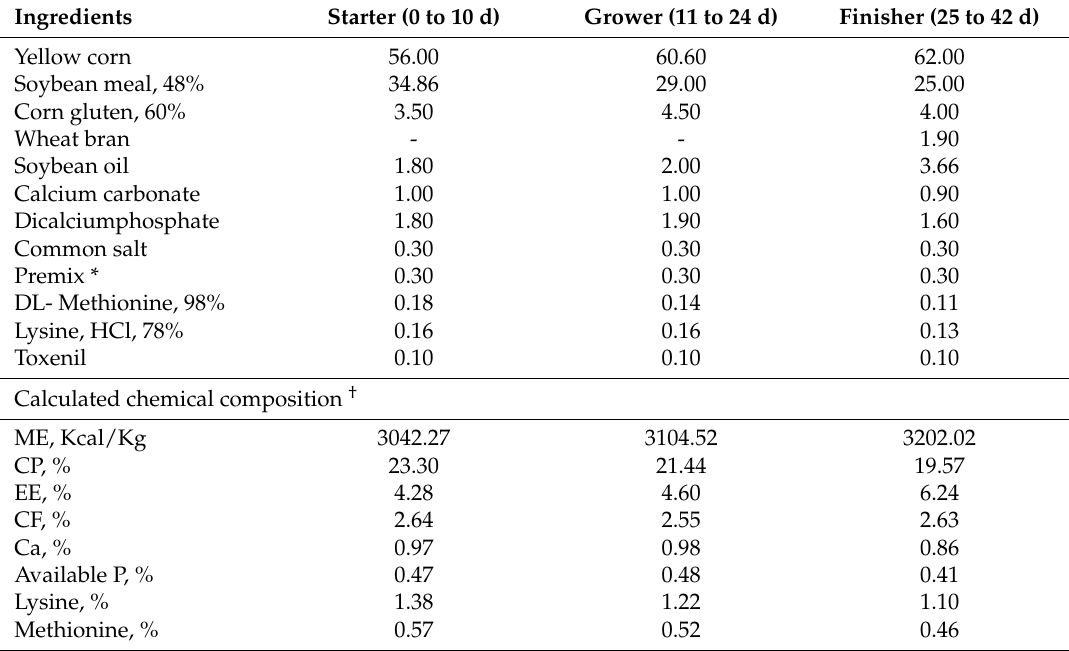
Table 1. Ingredients and chemical composition of basal diets (as-fed